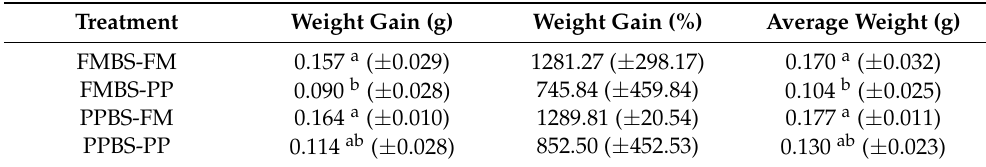
Table 3. Growth performance data obtained at 48 dph (end of the progeny feeding). Different letters indicate a statistical difference between groups ( p <